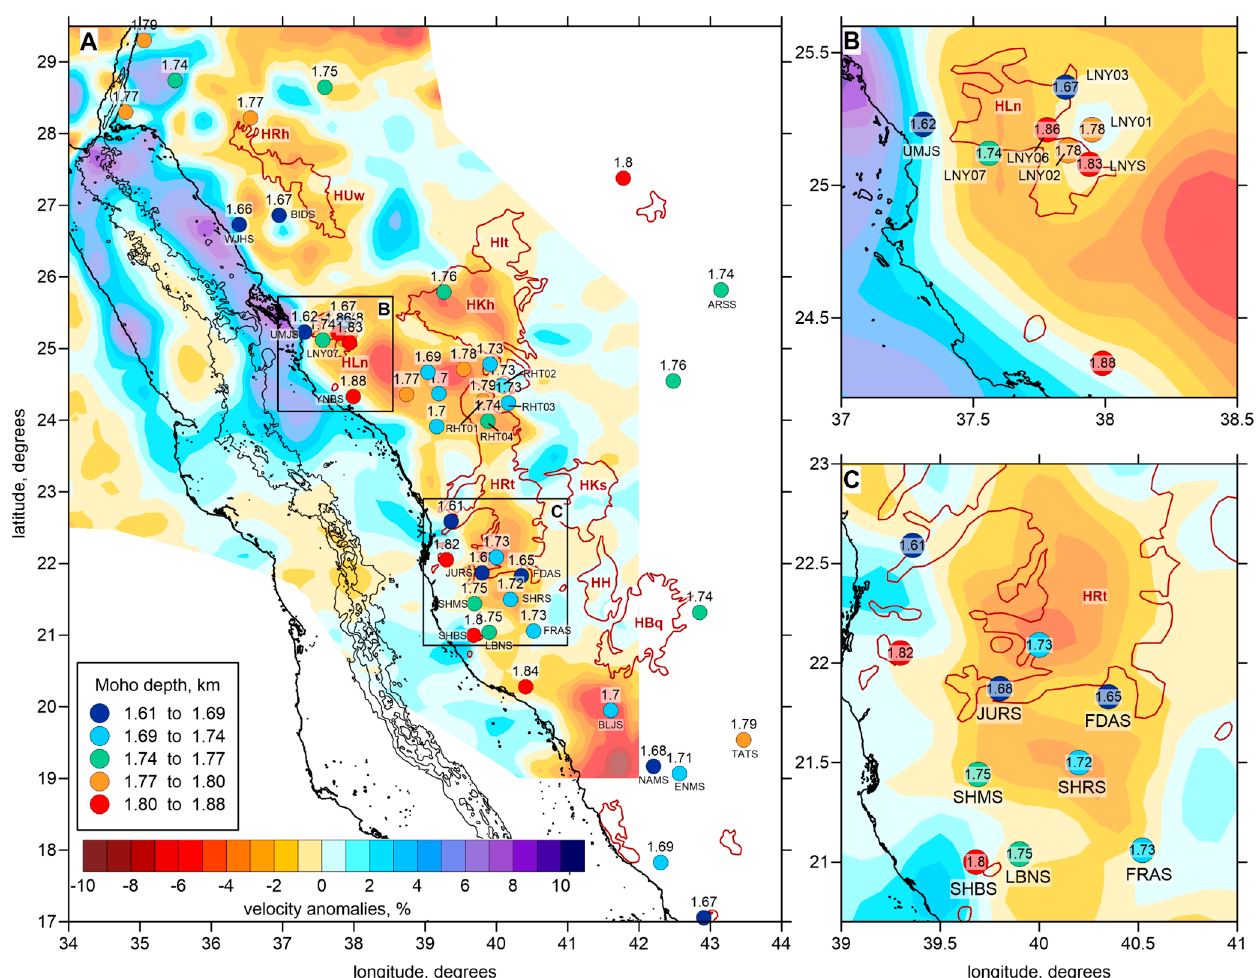
Figure 11. The resulting Vp/Vs ratios at seismic stations derived from the H-k stacking for the entire area of Western Arabia ( A ) and two enlarged areas ( B , C ). The values of the Vp/Vs ratio are indicated by colors of the circles and numbers. The names are indicated for the stations that are mentioned in the text. The background is the distribution of the P-wave velocity anomalies at the depth of 30 km from [4]. Abbreviations for harrats indicated by the dark-red characters: HRh-ar Rahah; HUw-Uwaytid; HIt-Ithnayn; HKh-Khaybar, HLy-Lunayyir; HRt-Rahat; HKs-Kishb; HH-Hadan; HBq-al Buqum.